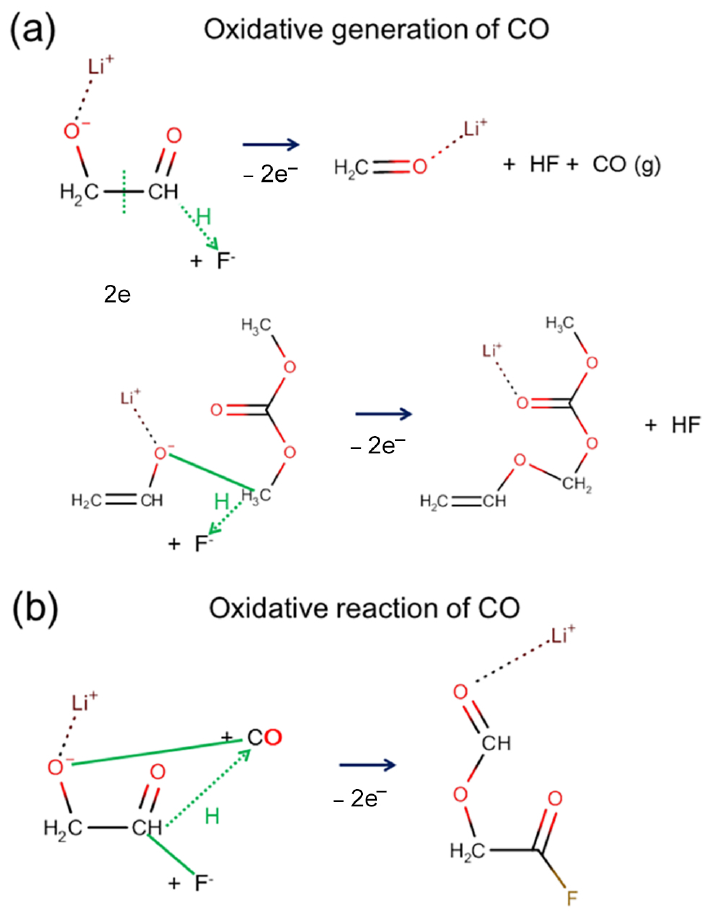
Figure 7. Two reaction pathways show that molecular CO can be either ( a ) generated or ( b ) consumed by the oxidative process. Solid green lines indicate bond formation, and dotted green lines with an arrow indicate hydrogen (proton)